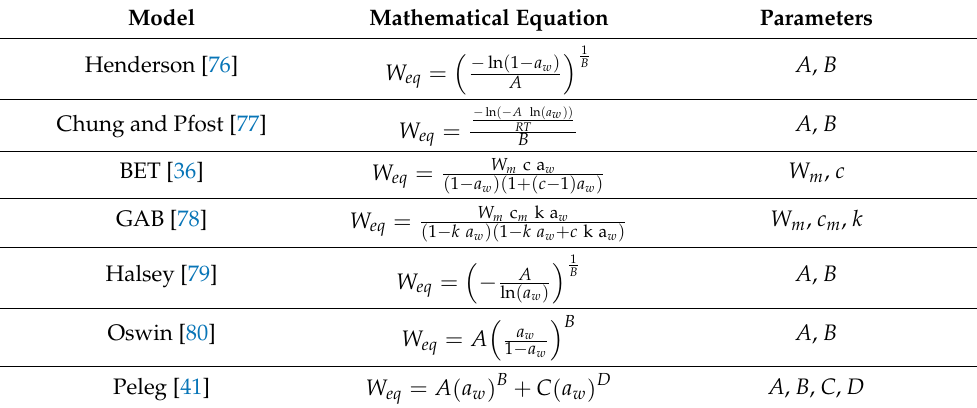
Table 5. Used models of the moisture desorption isotherm.